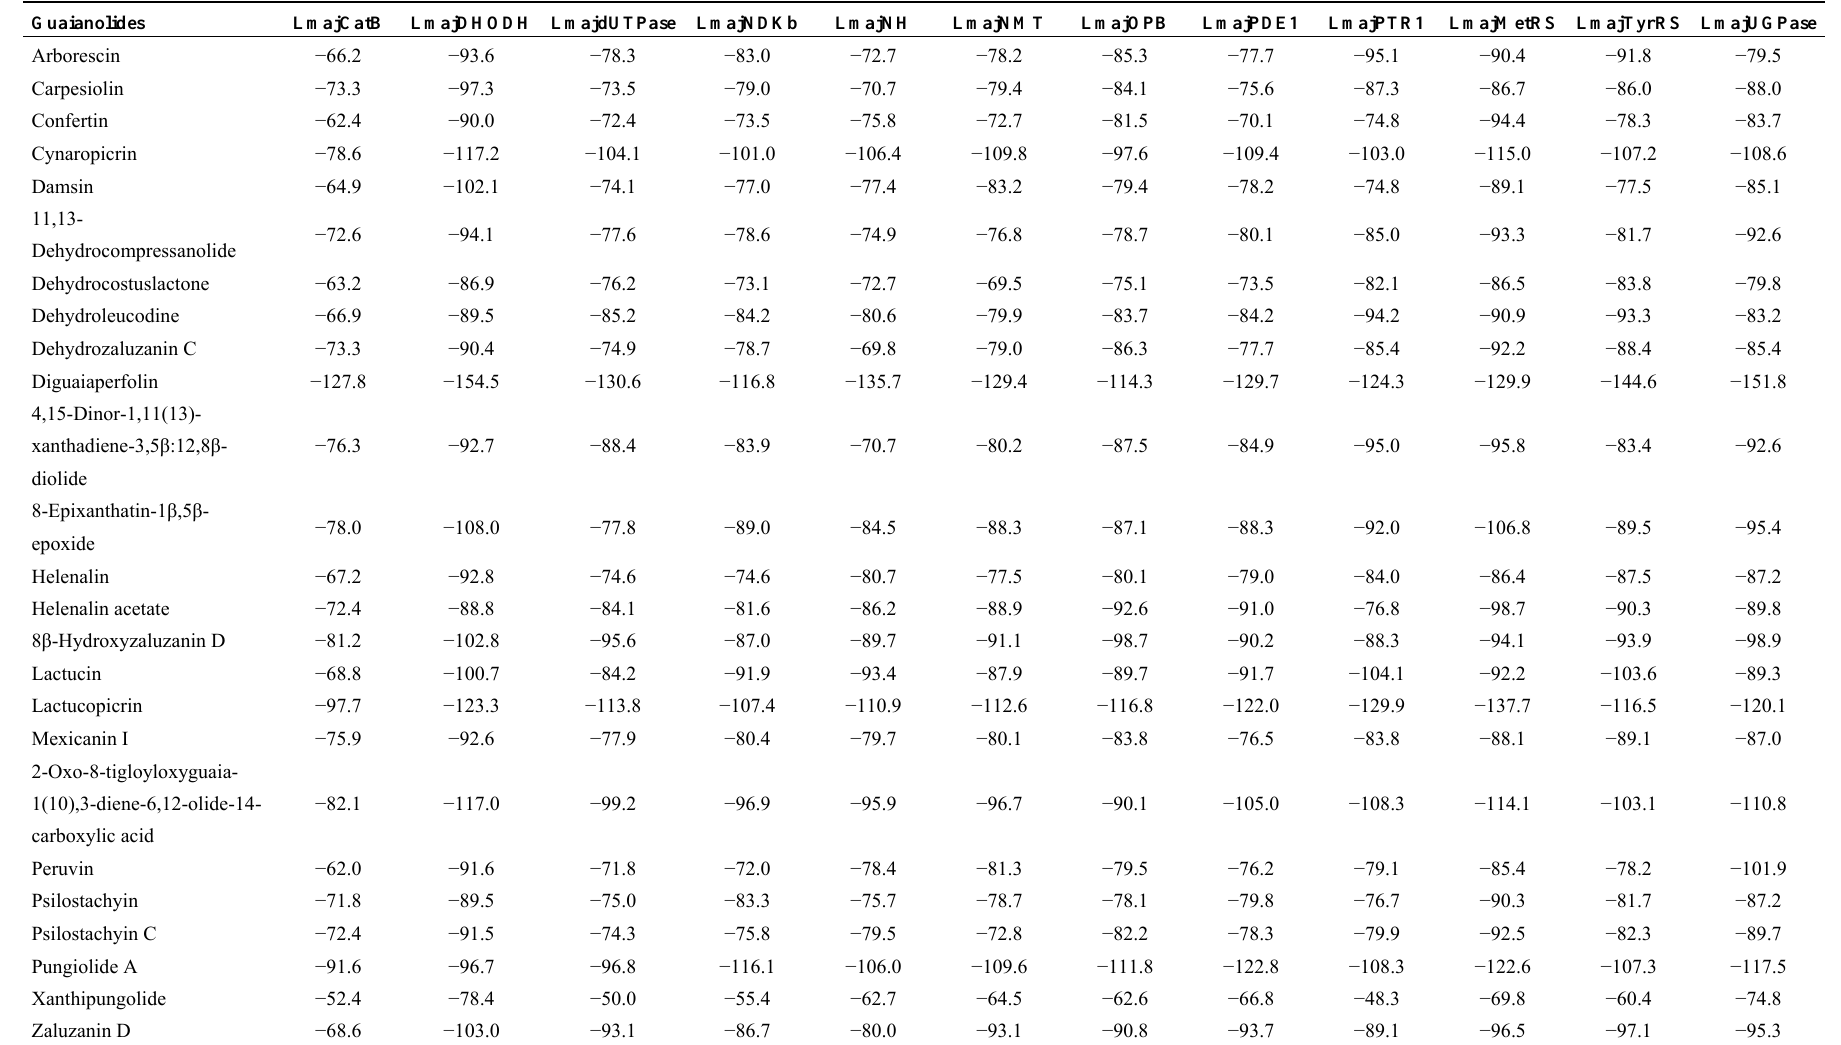
Table 7. MolDock docking energies (kJ/mol) of guaianolide sesquiterpenoids with Leishmania major protein